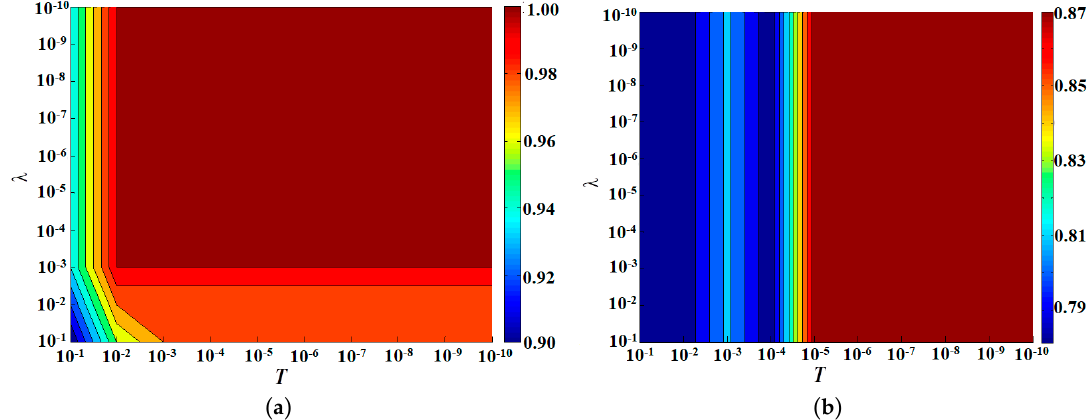
Figure 6. Influences of LRSC’s parameters on recognition effects of ( a ) the infrared spectral data and ( b ) LIBS data.